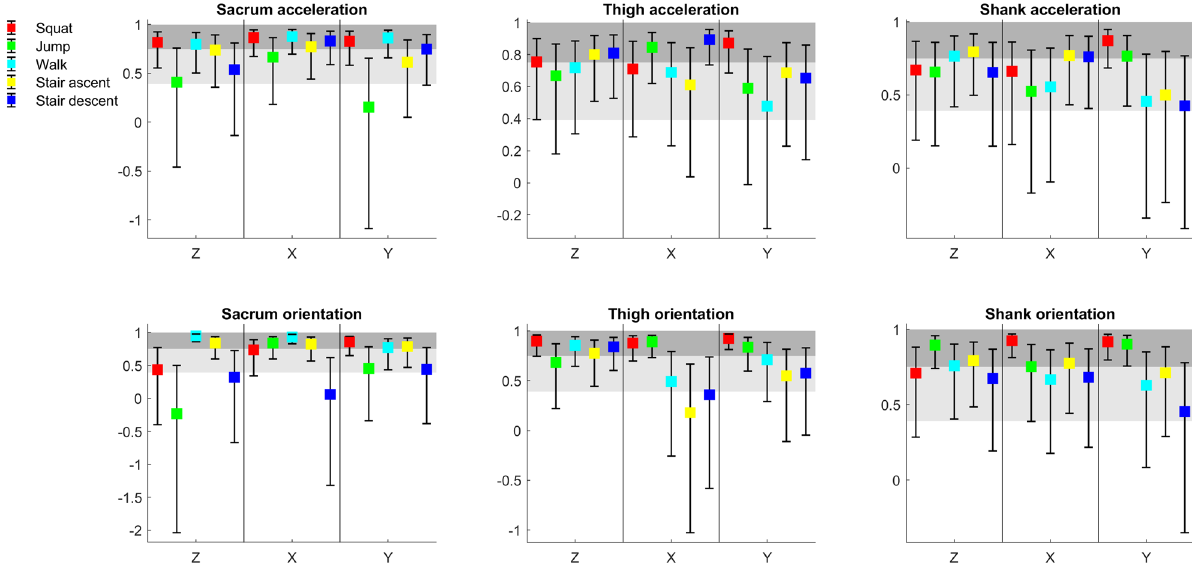
Figure 5. ICCs (95% CI) for acceleration and orientation range values (session 1 vs. session 2); light grey shaded areas indicate fair-to-high test–retest reliability; dark grey shaded areas indicate excellent test–retest reliability.